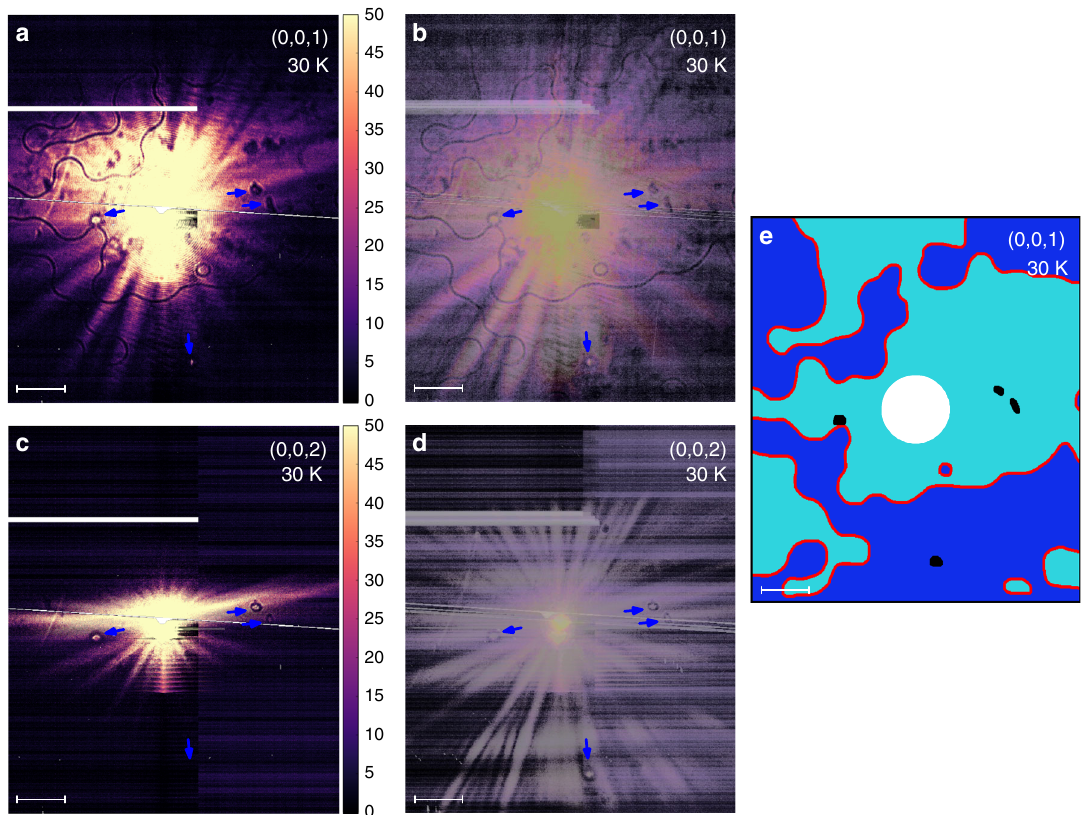
Fig. 3 Images of AFM antiphase domain boundaries. Single-exposure ( a ), ( c ), and stitched-together images ( b ), ( d ) at the magnetic (0,0,1) and structural (0,0,2) Bragg peak positions, as indicated. Black wavy lines in a and b are images of the antiphase domain boundaries. Arrows show structural defects. Horizontal scale bars (50 µ m) refer to the distances on the sample surface, as explained in the text. The reconstructed AFM domain pattern is shown in e . Black ovals indicate structural defects, white circle covers the area inaccessible due to detector saturation. All the detector images in this paper are elongated vertically by the factor of 1.15 to compensate for the beam footprint size effect and produce uniform magni fi cation, see the Methods section. Vertical color scale-bar units are